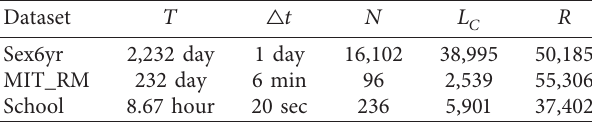
Table 1: Description of the three